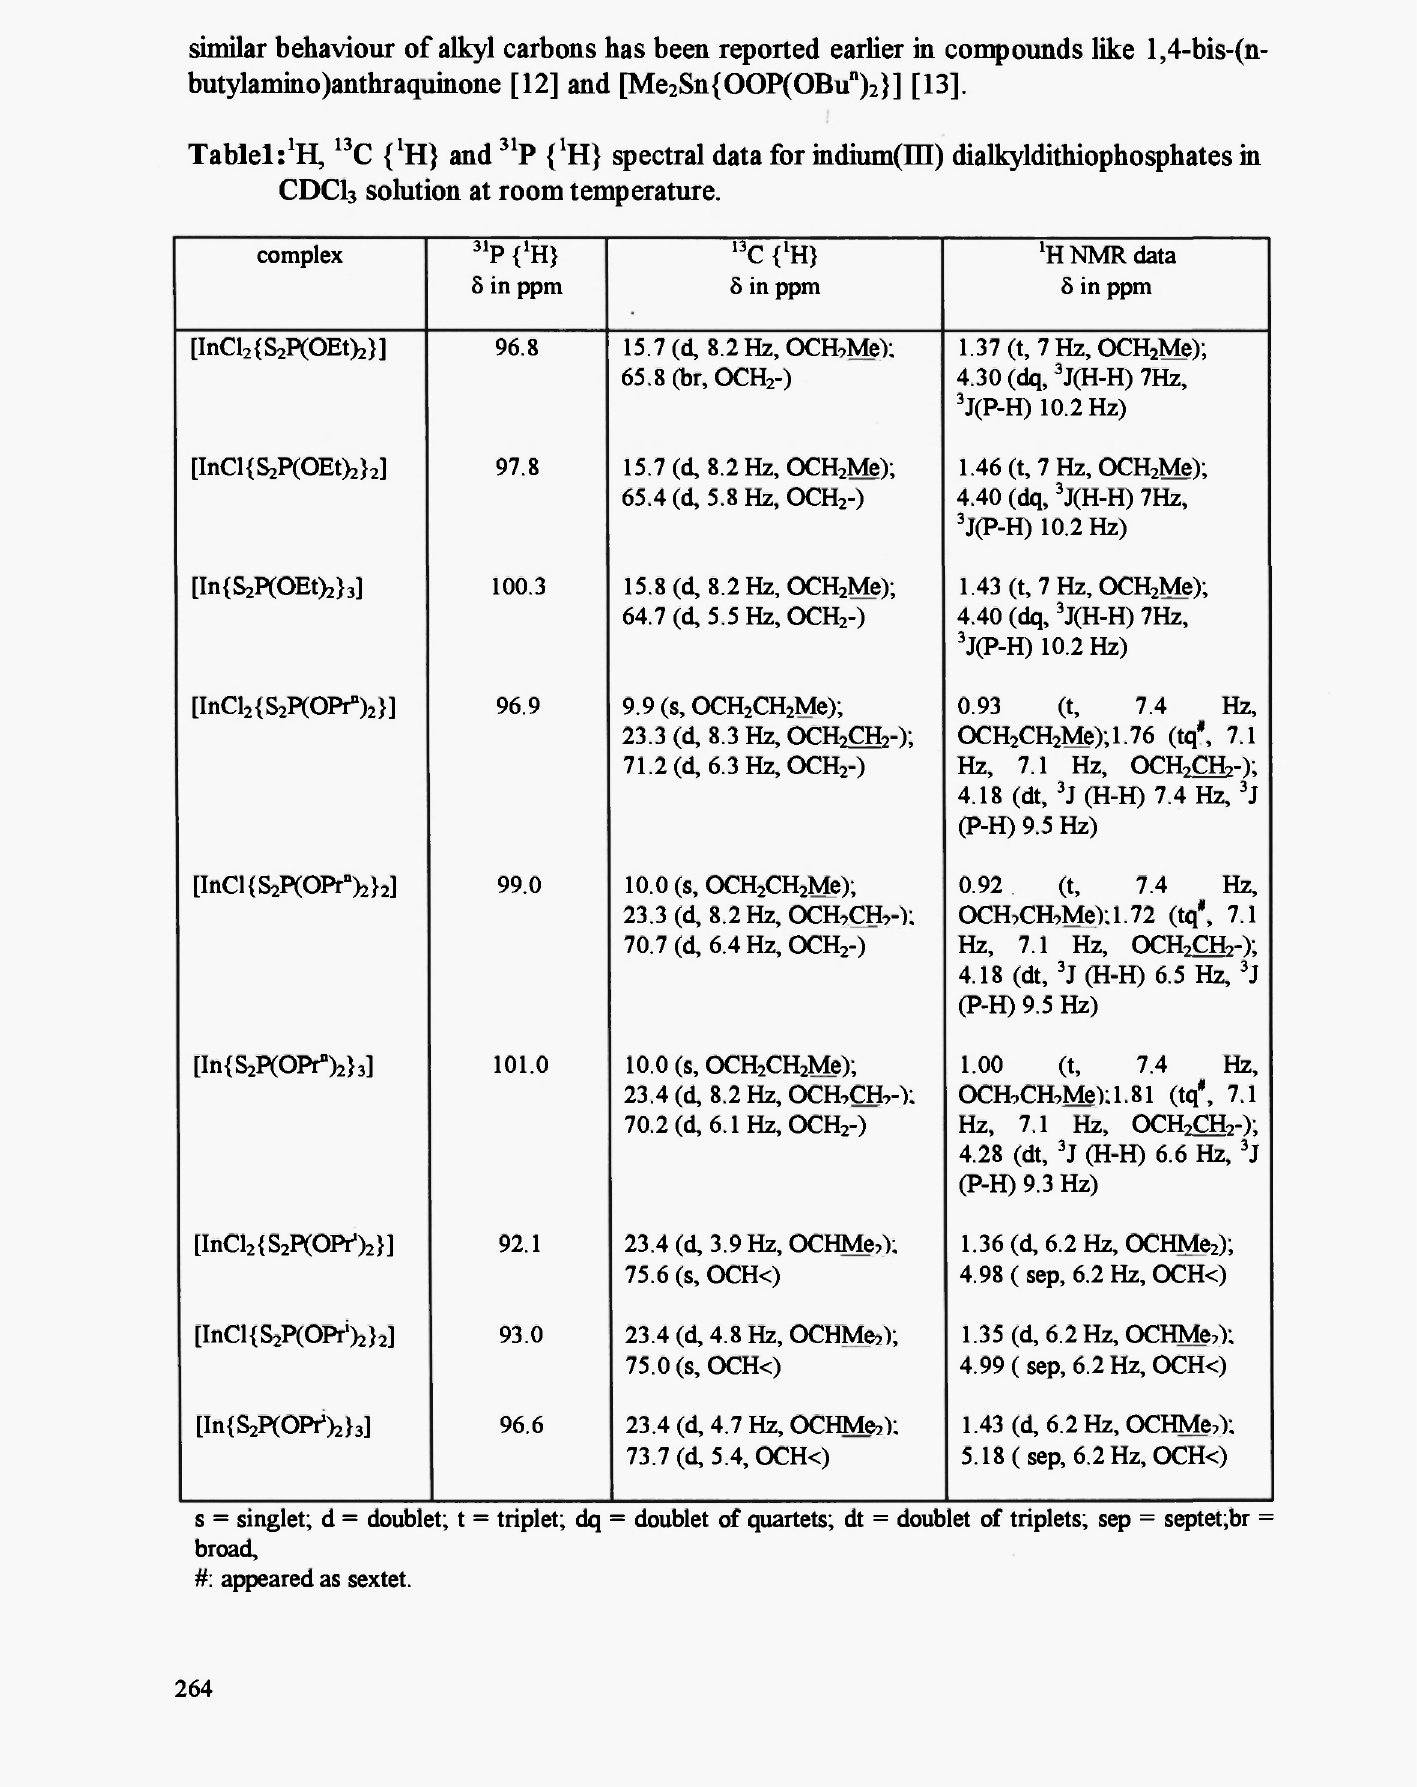
TablelVH, 13 C {'H} and 31 P ^ H} spectral data for indiurn (m) dialkyldithiophosphates in CDC1 solution at room 3